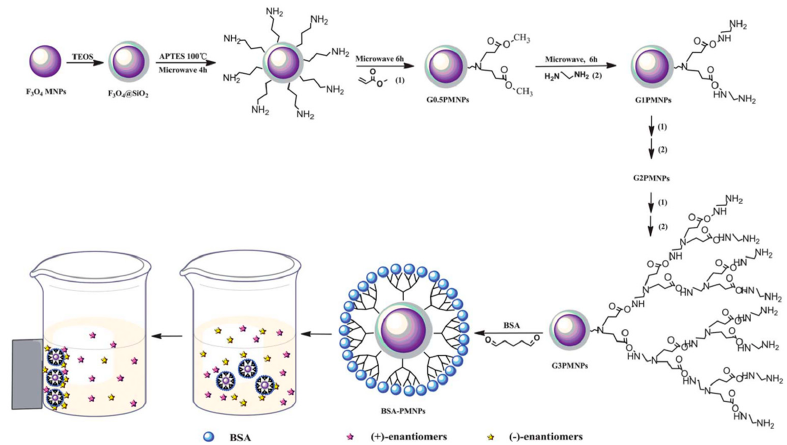
Figure 8. Preparation of BSA–PMNPs and the direct separation of the racemates. The figure and the caption have been adapted with permission from [66], Copyright © 2013 The Royal Society of Chemistry.